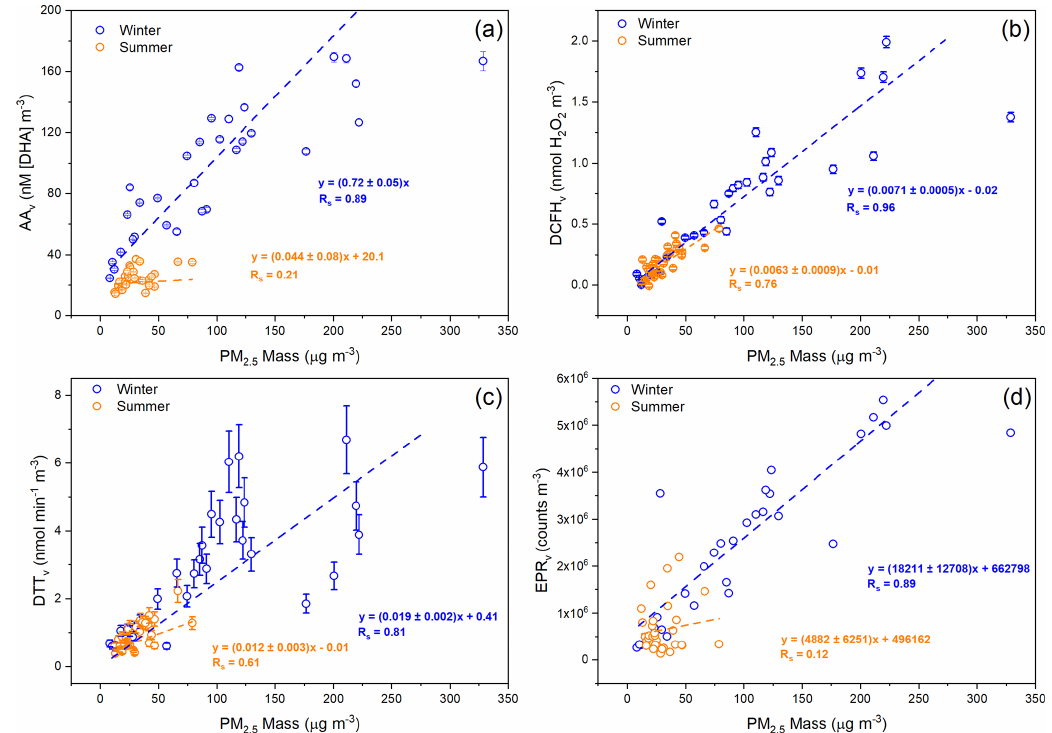
Figure 2. Comparison of PM 2 . 5 OP v during winter 2016 (blue) and summer 2017 (orange) vs. PM 2 . 5 mass (µgm − 3 ). (a) AA v , (b) DCFH v , (c) DTT v and (d) EPR v . Each data point represents a 24h average for OP measurements and PM 2 . 5 mass. Corresponding R s and linear fit equations are included. For AA v , DCFH v and DTT v , error bars represent the standard deviation observed over three repeat measurements for each filter sample, and in some cases the error is smaller than the data point. Uncertainty values are unavailable for EPR v measurements.